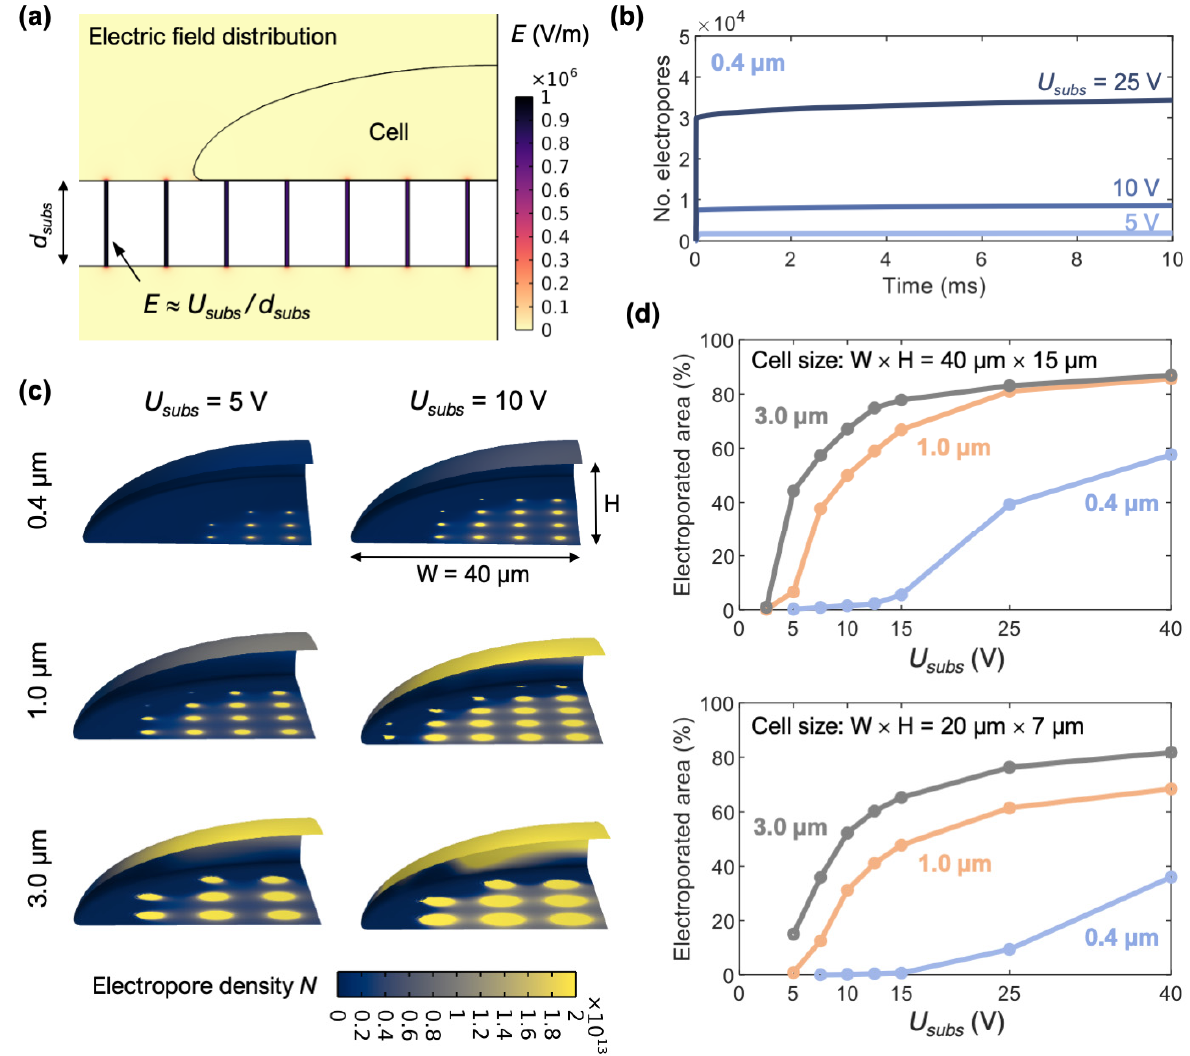
Figure 2. Numerical modeling investigating electroporation of a cell growing on porous substrate. ( a ) Electric field distribution within and around the substrate pores. ( b ) Time course of the total number of electropores induced by a 10-ms-long pulse of given U subs voltage applied at time 0 s. Results are shown for substrate with 0.4 µm pores and for cell with dimensions 40 µm × 15 µm. ( c ) Spatial distribution of the number density of electropores within the cell membrane at the end of a 10 ms pulse. Results are shown for substrates with three different pore sizes and for two different values of U subs . ( d ) Electroporated fraction of the cell membrane, determined as the relative area in which the electropore density exceeds 10 13 m − 2 . The two graphs correspond to calculations for cells with two different sizes. The electroporated area was computed for U subs = {1, 2.5, 5, 7.5, …} V; absence of a data point at these values means that the electropore density is below 10 13 m − 2 everywhere in the cell membrane.